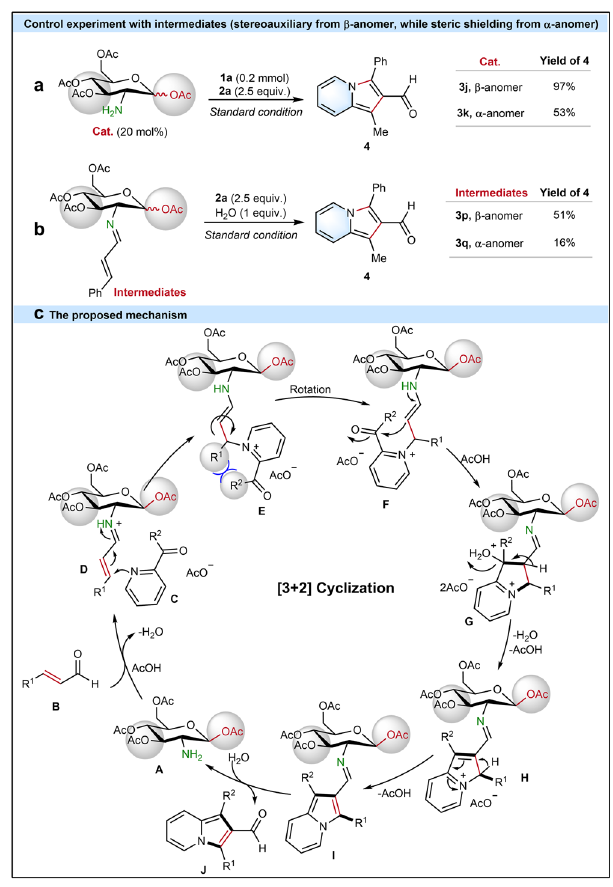
Fig. 6 Stereoauxiliary control experiments. a Control experiment with 3j ( β -anomer) and 3k ( α -anomer). b Control experiment with intermediate 3p ( β -anomer) and intermediate 3q ( α -anomer). c Proposed